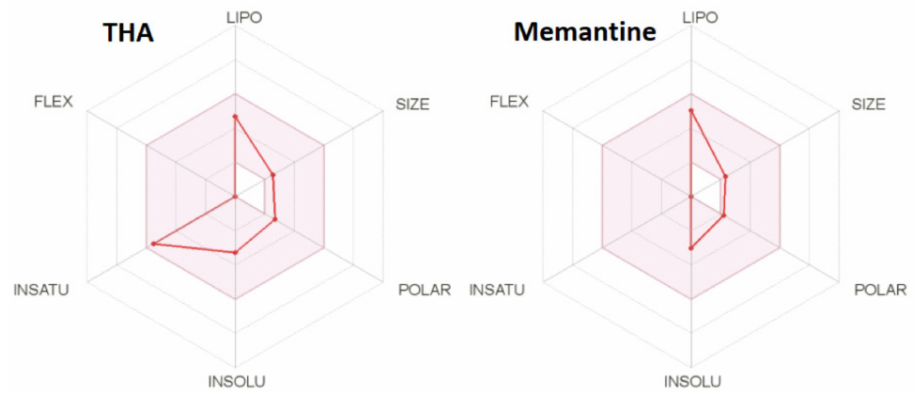
Figure 3. The bioavailability radar chart for the standards THA and memantine (please see detailed description in the